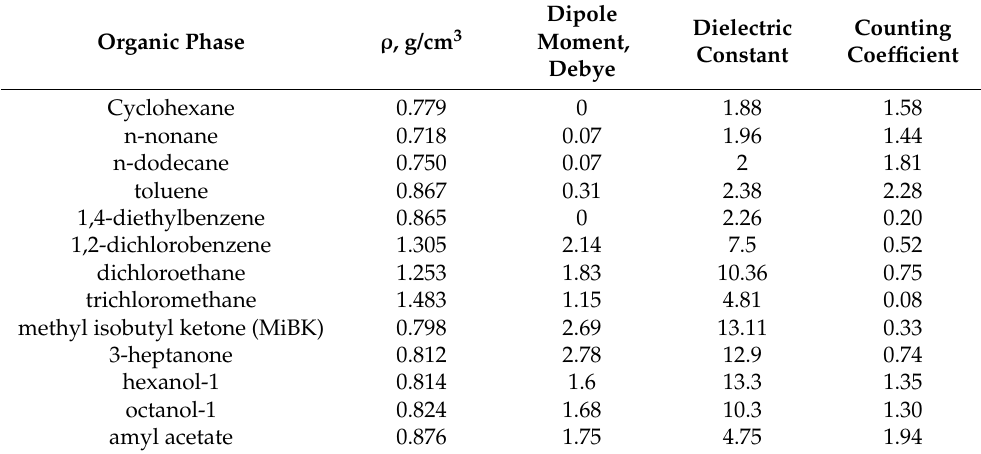
Table 1. Used organic phases and their